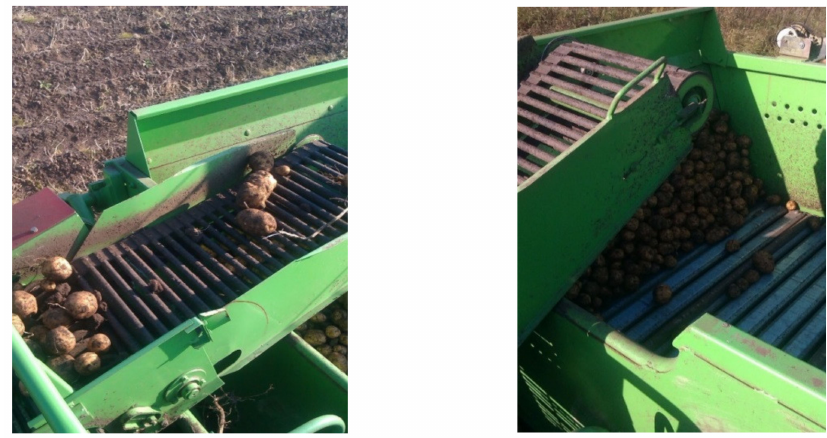
Figure 1. General view of the tuberous heap in the bunker of a potato harvester.